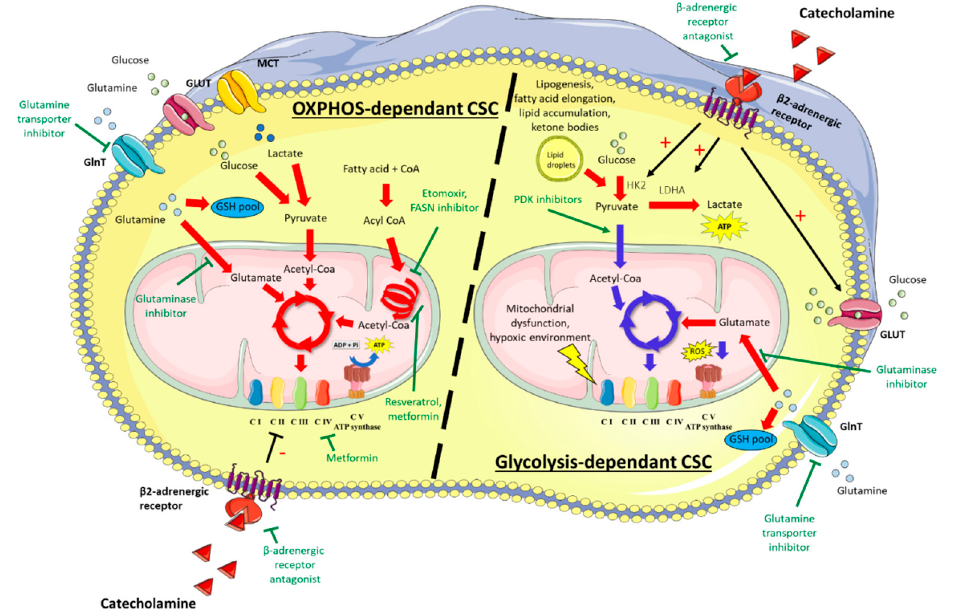
Figure 2. Glycolysis- or OXPHOS-dependent cancer stem cells. Depending on tissue location and quiescence/proliferation status, CSC preferentially use glycolysis or OXPHOS to meet their energy needs. Glycolysis-dependent CSC are characterized by increased lactate production and/or glutaminolysis. Catecholamines favor the glycolytic profile by increasing the expression of glucose transporters and key glycolytic enzymes (HK2, LDHA). Lower use of OXPHOS reduces the ROS production. In OXPHOS-dependent CSC, the TCA cycle is fed from glucose, glutamine, and fatty acids. Metabolic-targeted therapies under investigation are indicated in green. Red arrows indicate intensified signaling pathways and blue arrows indicate reduced signaling pathways. CSC: cancer stem cell; OXPHOS: oxidative phosphorylation, ROS: reactive oxygen species; HK2: hexokinase 2; LDHA: lactate dehydrogenase A; GSH: glutathione; GLUT, glucose transporter; GlnT, glutamine transporter; MCT, monocarboxylate transporter; CI: complex I of the respiratory